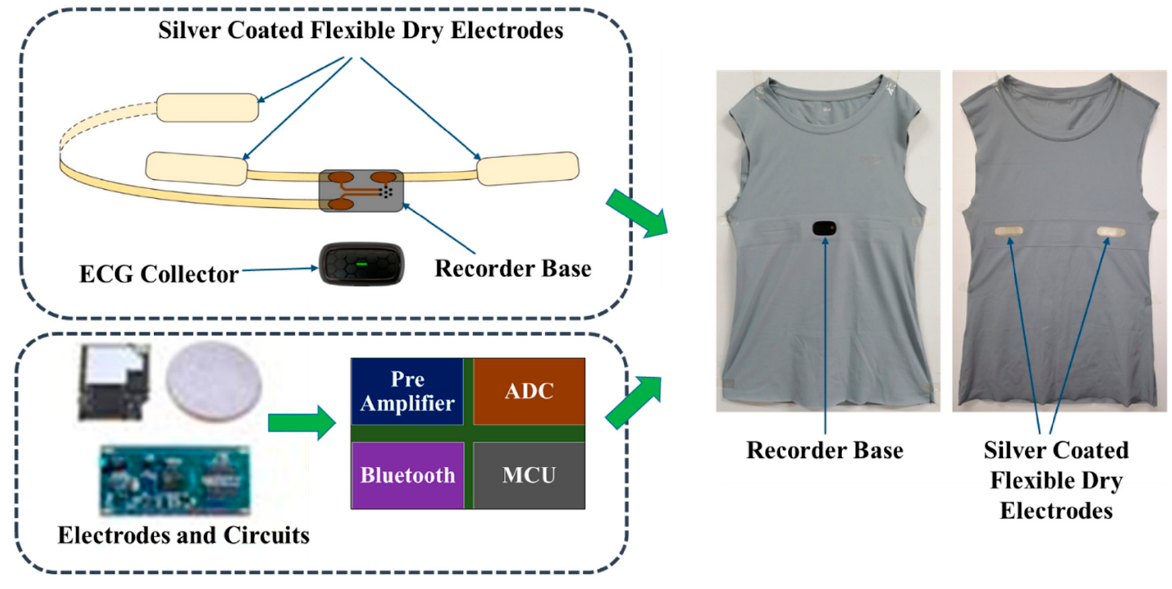
Figure 1. ECG acquisition system of the wearable smart T-shirt used in this study. A wearable smart T-shirt has three silver-coated dry electrodes, one smart textile, one recorder base, and one ECG collector [56,57]. The ECG signal is transferred through Bluetooth in display devices, such as smartphones, computers, laptops, and tablets.